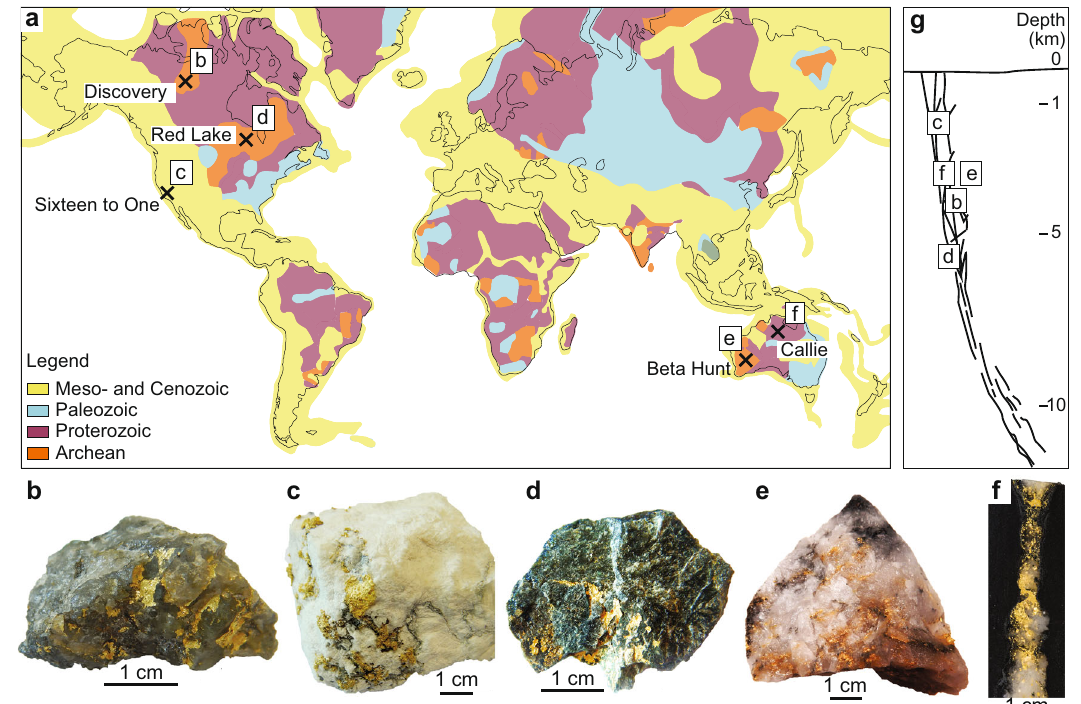
Fig. 1 Sample location and description. a Location of the deposits from which samples were collected for this study; the deposit locations are shown on a world map indicating the thermo-tectonic age of the country rocks, modi fi ed from USGS thermo-tectonic data 50 . b to f show photographs of the gold-rich quartz vein specimen used in this study: b Discovery; c Sixteen to One; d Red Lake; e Beta Hunt; f Callie. g Schematic cross-section showing the estimated depth of formation of the deposits